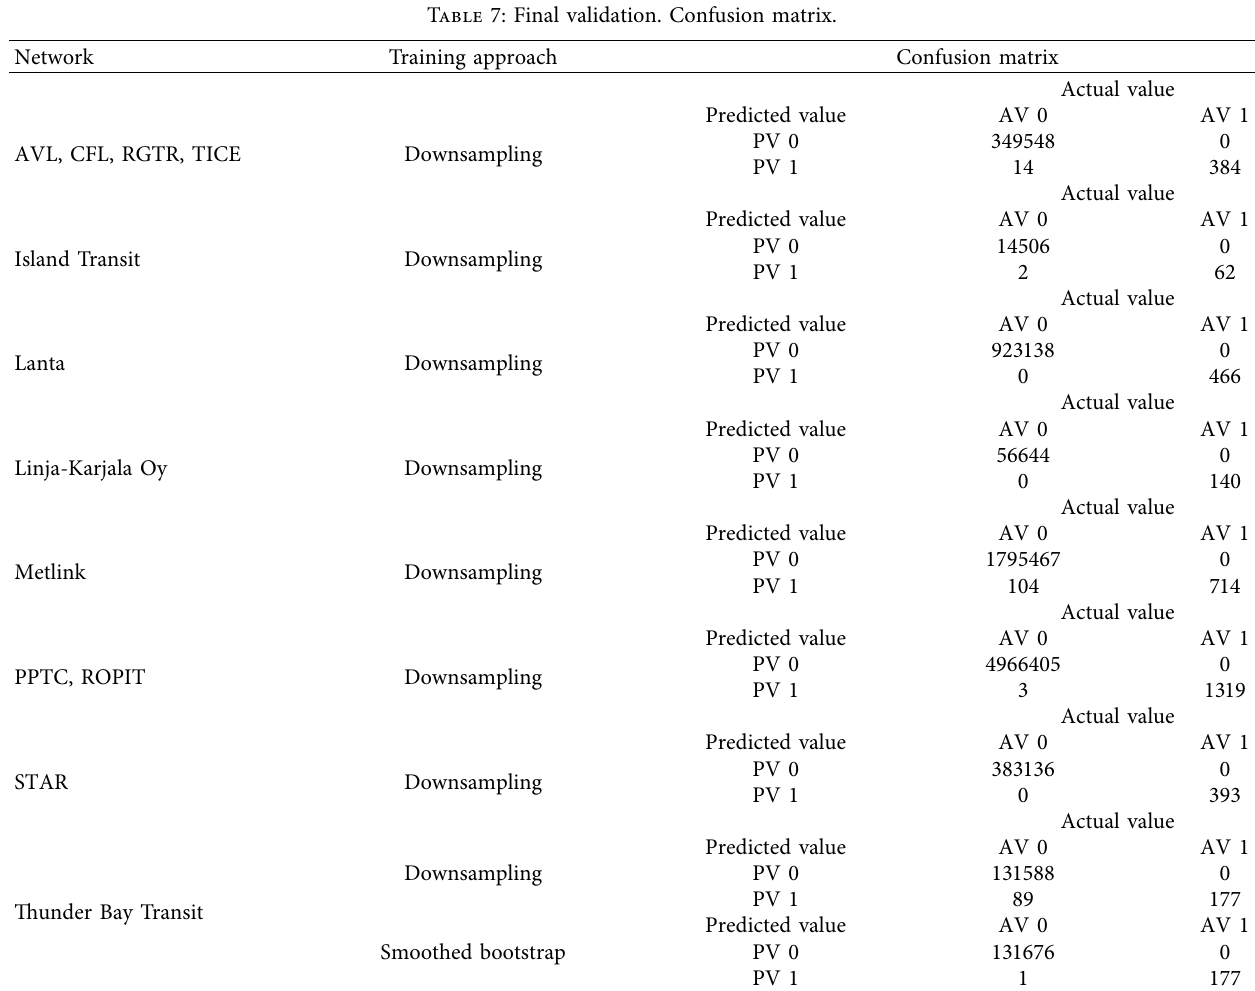
Table 7: Final validation. Confusion